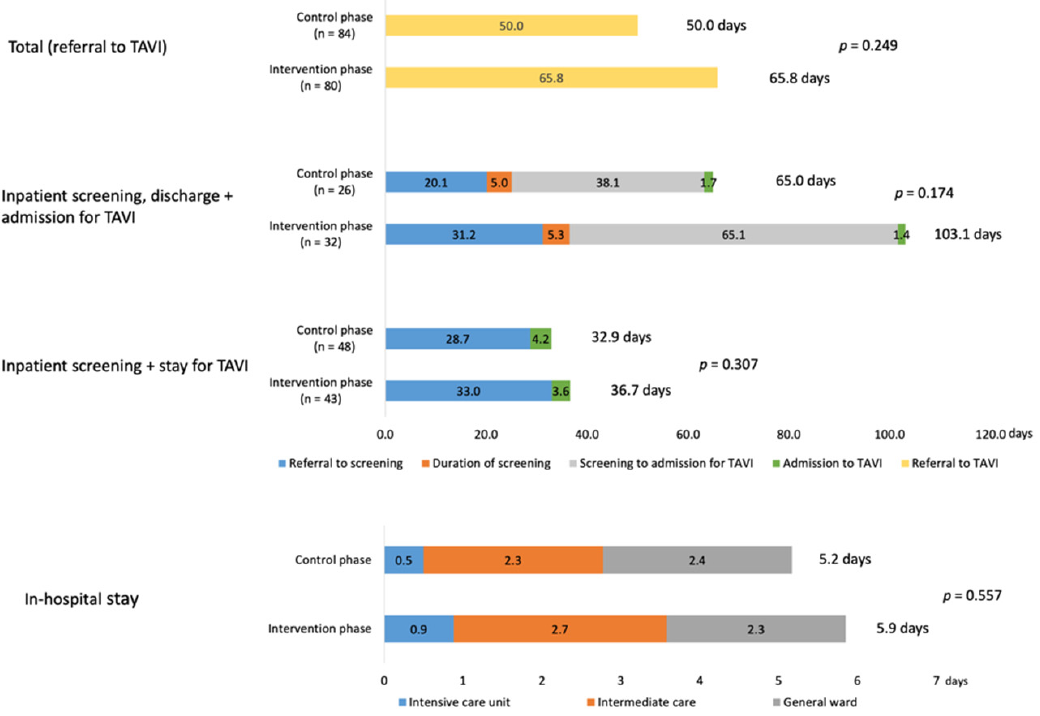
Figure 3. Timeline from referral to TAVI and in-hospital stay for control vs. intervention phases. For the total population, breakdown of the timeline into ‘referral to screening’, ‘duration of screening,’ and ‘time between screening and TAVI’ was not possible because of the need to account for time spent in post-screening discharge for the subgroup of patients who were discharged after screening before later re-admission for the TAVI procedure. TAVI, transcatheter aortic valve implantation. The time between TAVI and discharge from hospital was 5.2 vs. 5.9 days in the con- trol vs. the intervention phase. ICU and IMC unit stays were slightly longer in the inter- vention phase (Figure 3). 3.5. Outcomes: Staff Working Hours Overall, the implementation of a TAVI coordinator reduced staff working hours (Fig- ure 4), including for nursing staff (15.6 vs. 14.2 h/TAVI patient; p = 0.001) and medical technical assistants (6.2 vs. 5.3 h; p = 0.008). The main reasons were a significant reduction in time for diagnostics and operating room attendance, but time spent on patient admis- sion ( p = 0.018) and the general ward ( p = 0.041) was also reduced for nurses. As expected, the TAVI coordinators’ workloads increased after they assumed the coordinator role (1.5 vs. 2.9 h; p < 0.001).